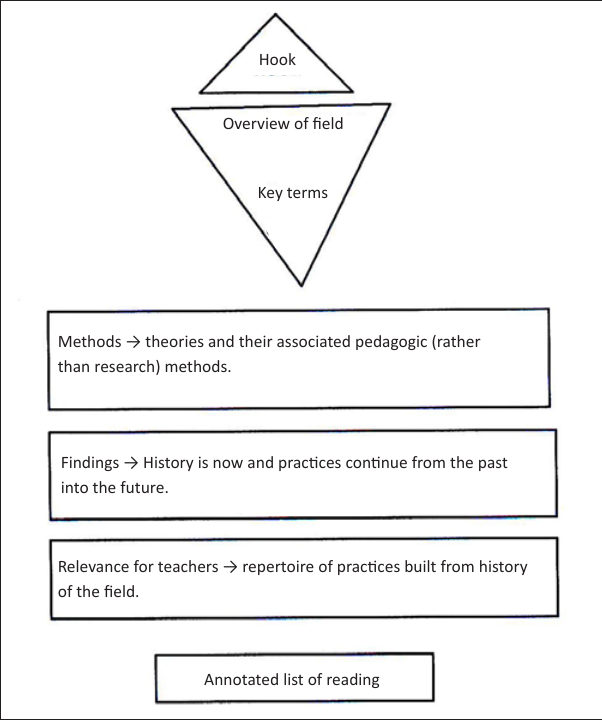
FIGURE 7: The final structure that solved the mismatch between the structural requirements and the way the paper was